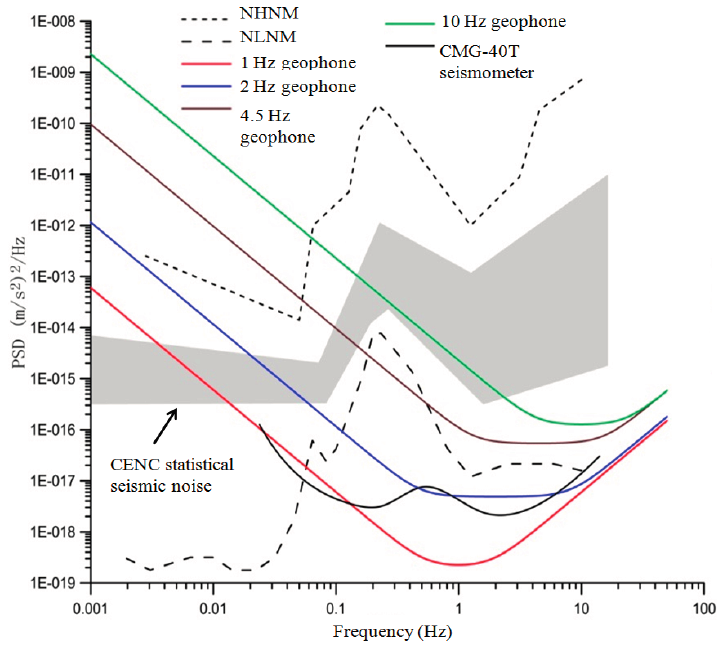
Figure 1. Power spectrum density comparison of four geophones (1, 2, 4.5, and 10 Hz) and the CMG-40T